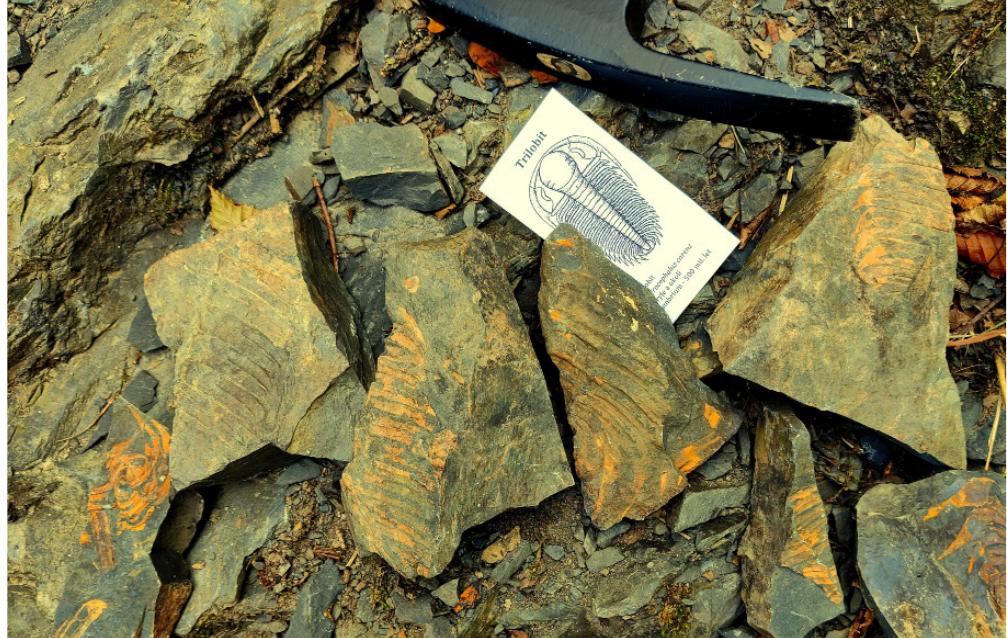
Figure 2. Trilobites of the genus Hydrocephalus described by J. Barrande (middle Cambrian) found at the pub- licly accessible Skryje-Luh